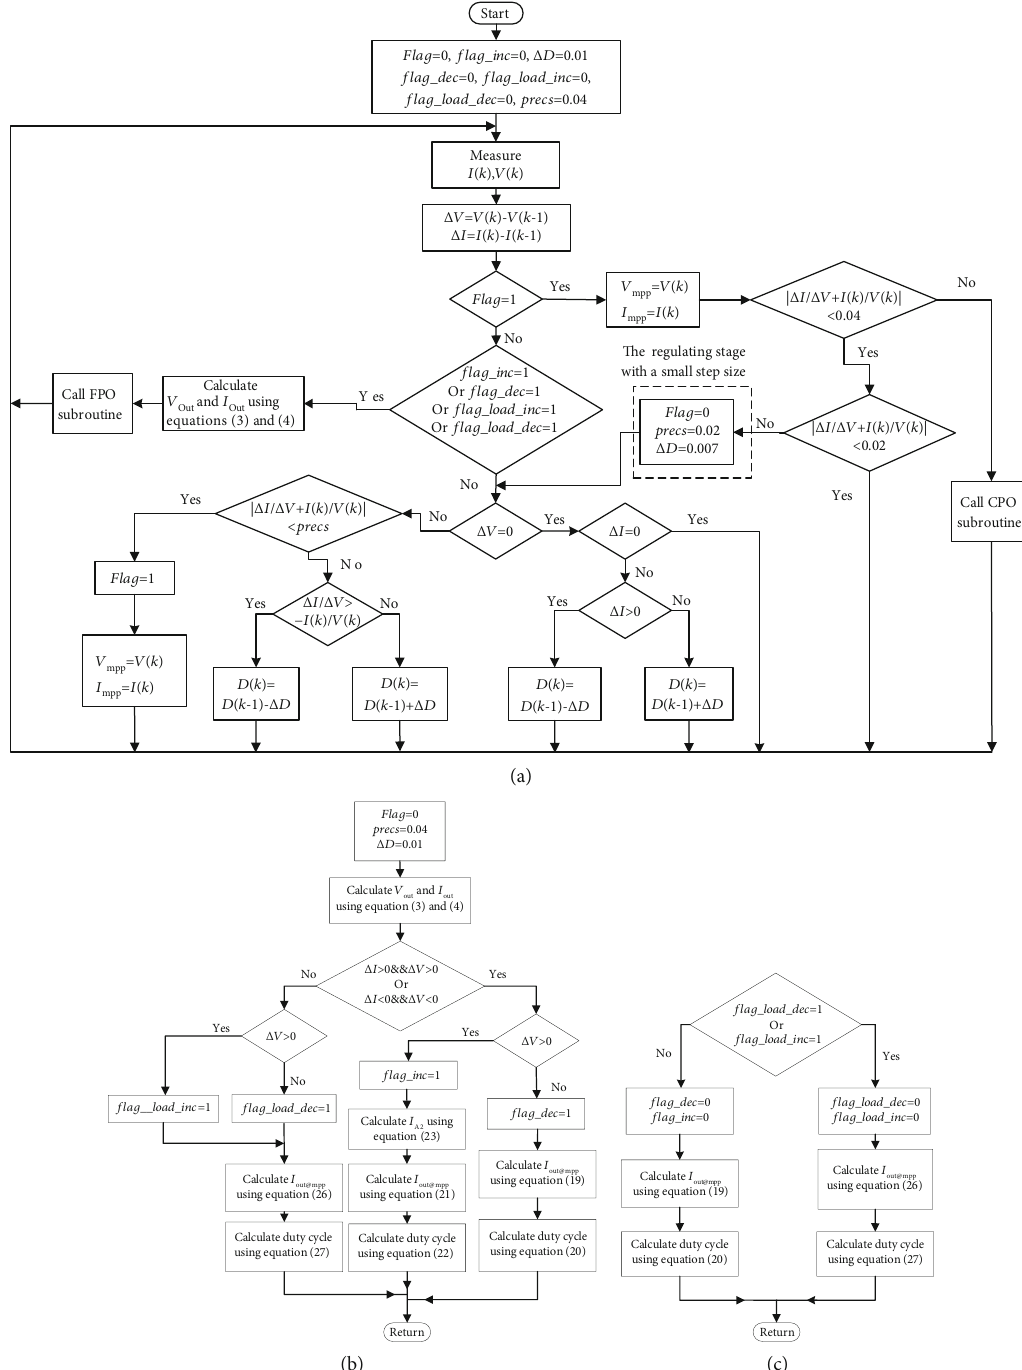
Figure 6: Flowchart of the proposed algorithm: (a) main program; (b) CPO subroutine; (c) FPO